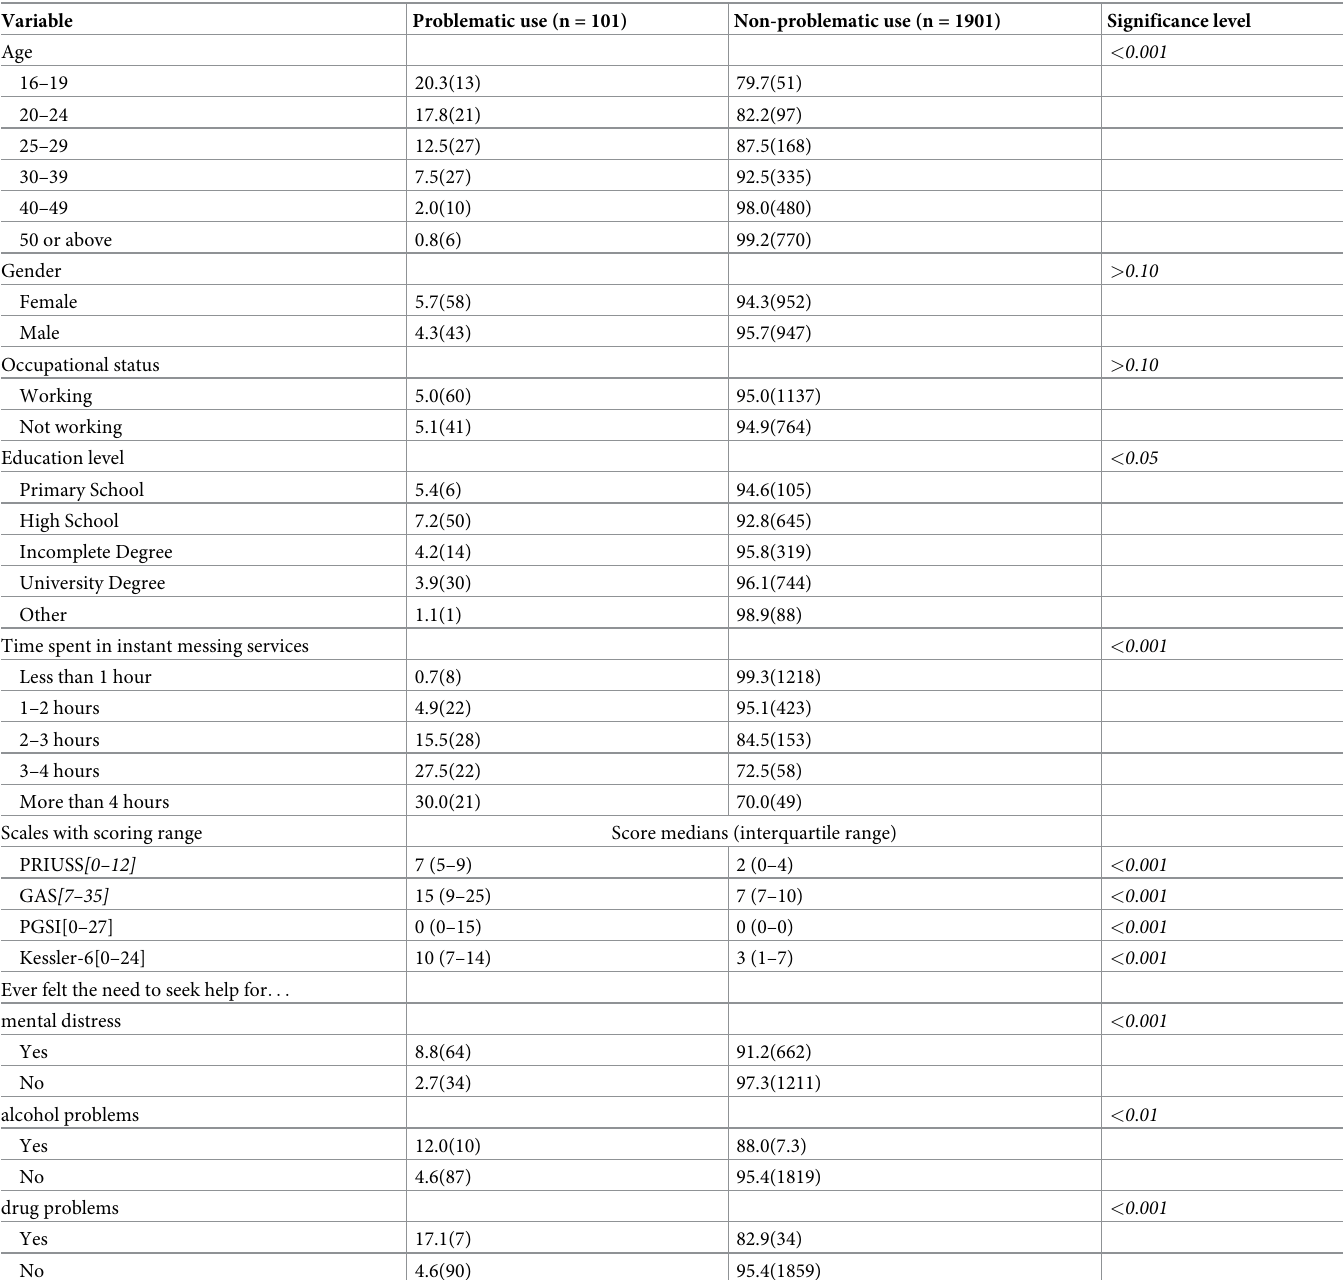
Table 2. Variables potentially associated with problematic social media use, %(n), unadjusted analyses. All individuals included (N =